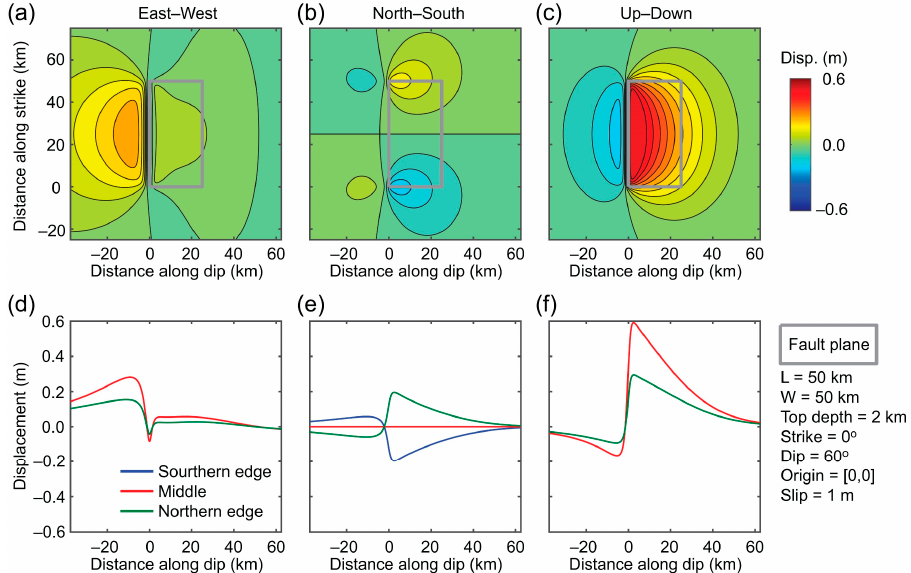
Figure 7. Spatial distributions ( a – c ) and cross-sectional profiles ( d – f ) of fault displacements in east– west ( a , d ), north–south ( b , e ), and up–down ( c , f ) directions due to a fault rupture with unit slip in a reverse faulting mechanism.